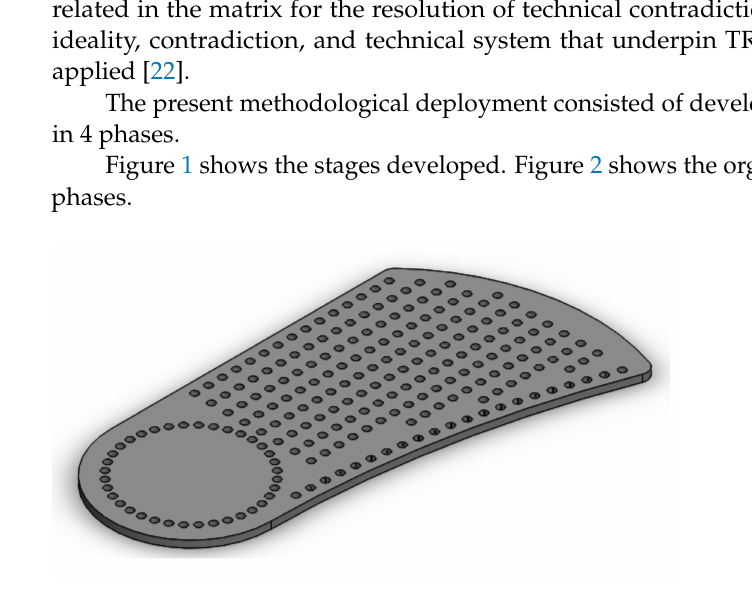
Figure 1. Plantar base as seen from the